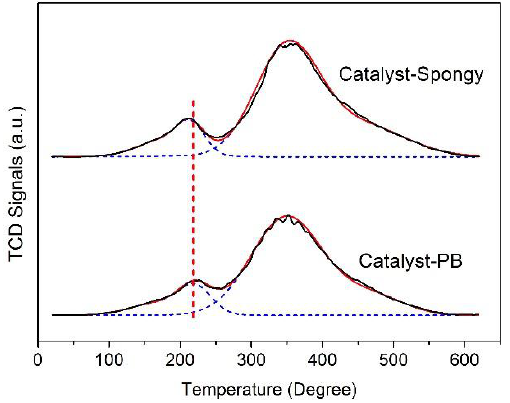
Figure 6. TPR profiles of the sulfurized CoMo/Al 2 O 3 catalysts using different support.